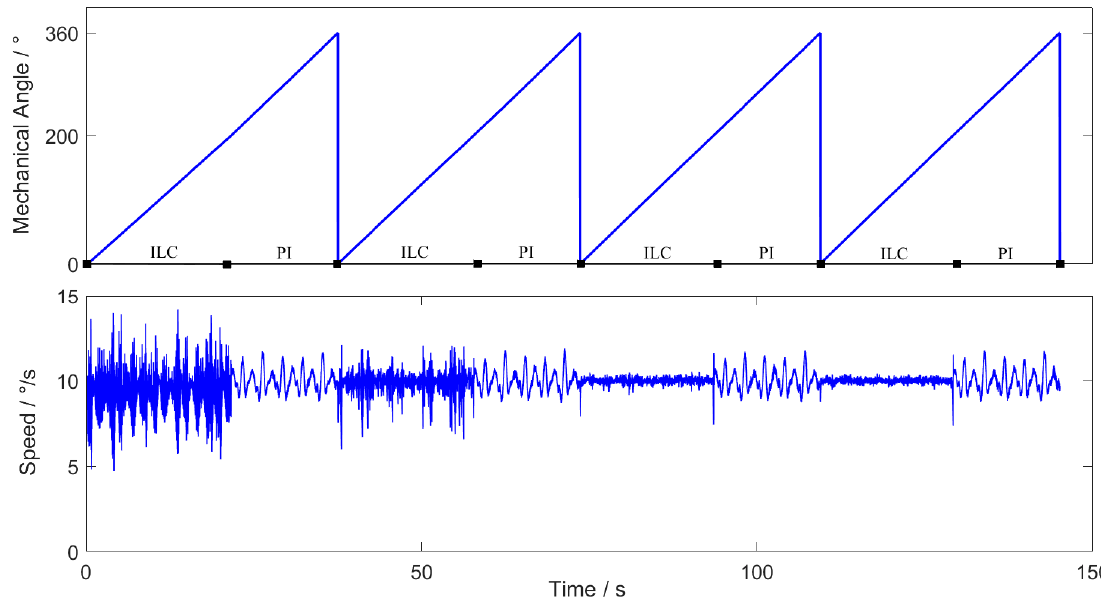
Figure 4. Experimental results of ILC.